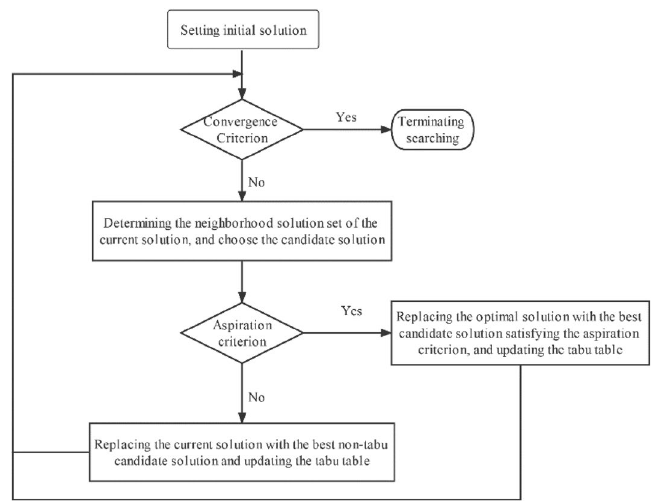
Figure 4. Detailed steps of the